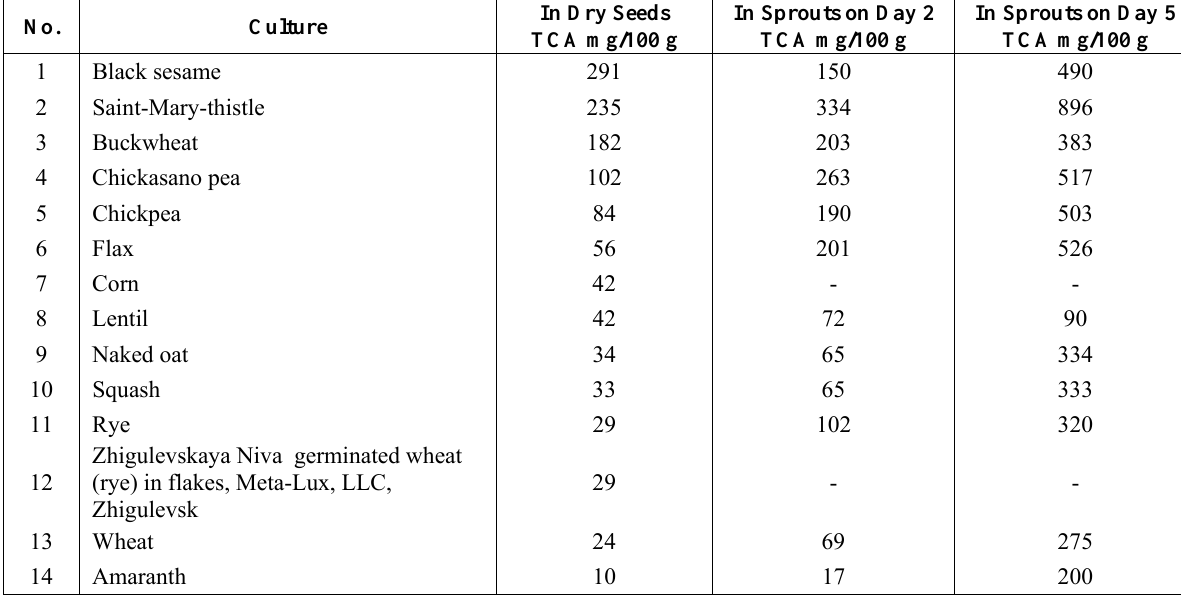
Table 12. Total Content of Antioxidants (TCA) in Seeds & Sprouts of Various Cultures Based on Absolutely Dry Weight (standard –